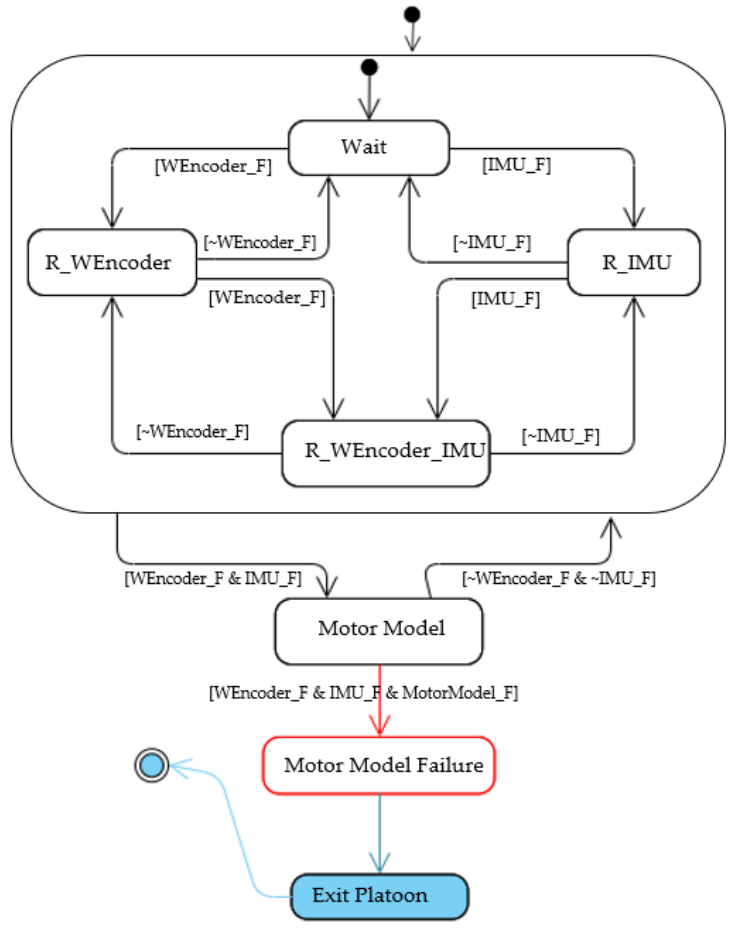
Figure 12. R-STD for ego-motion estimation failure.